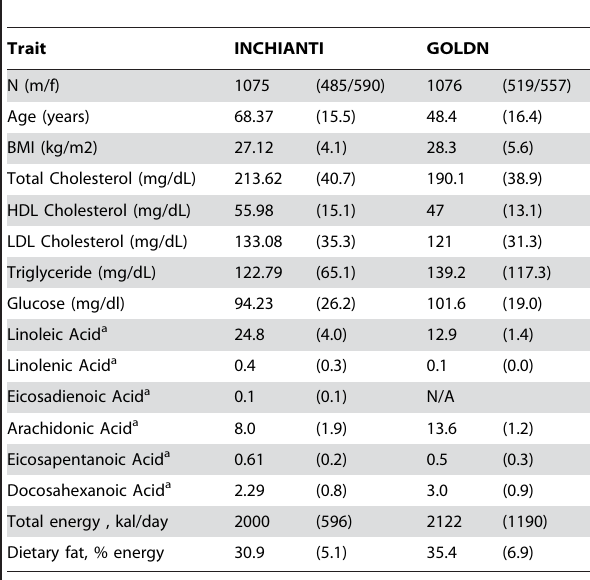
Table 1. Descriptive Characteristics of InCHIANTI and GOLDN